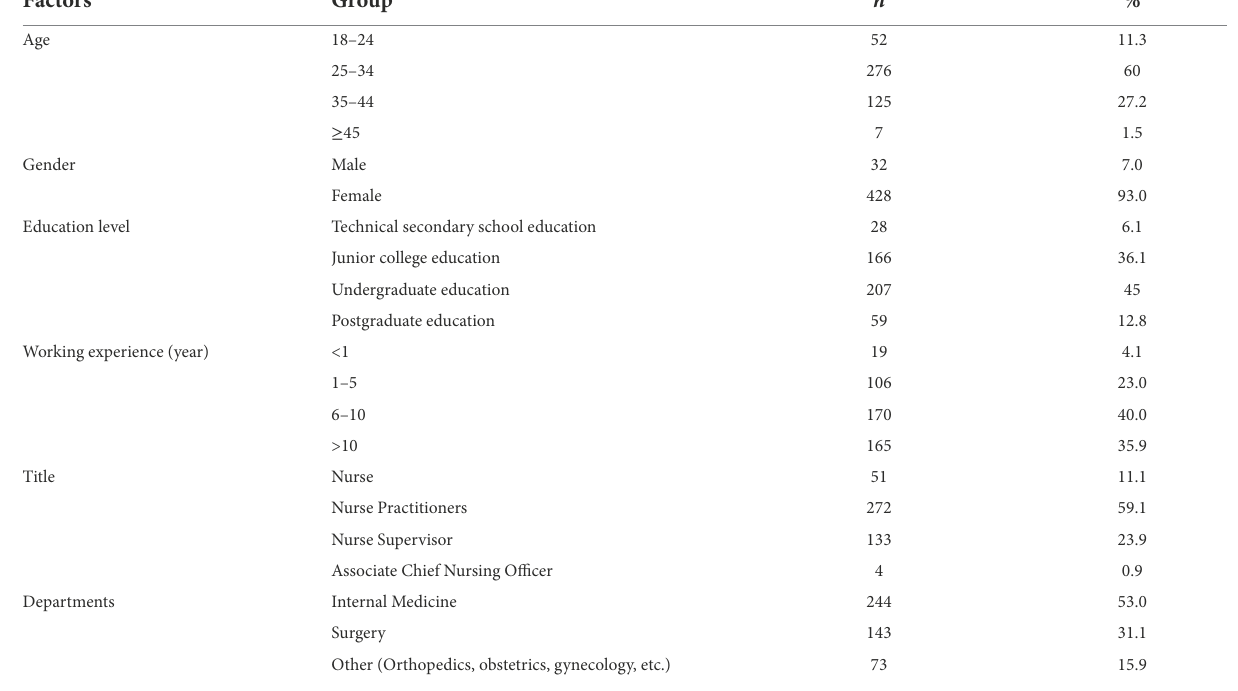
TABLE 1 Frequency distribution of demographic characteristics ( n = 460).